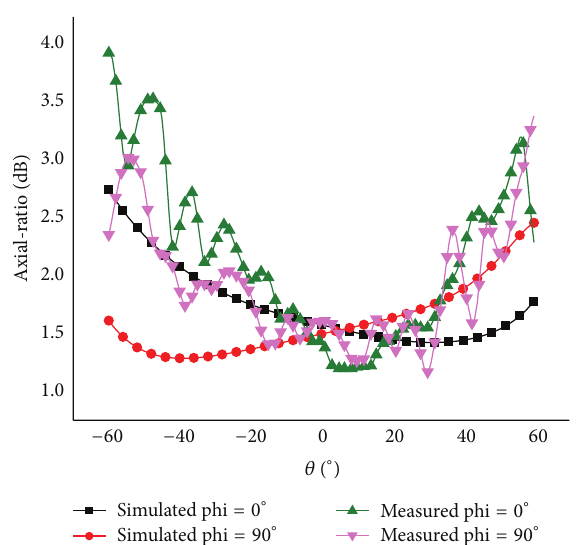
Figure 13: Axial-ratio at the zenith versus